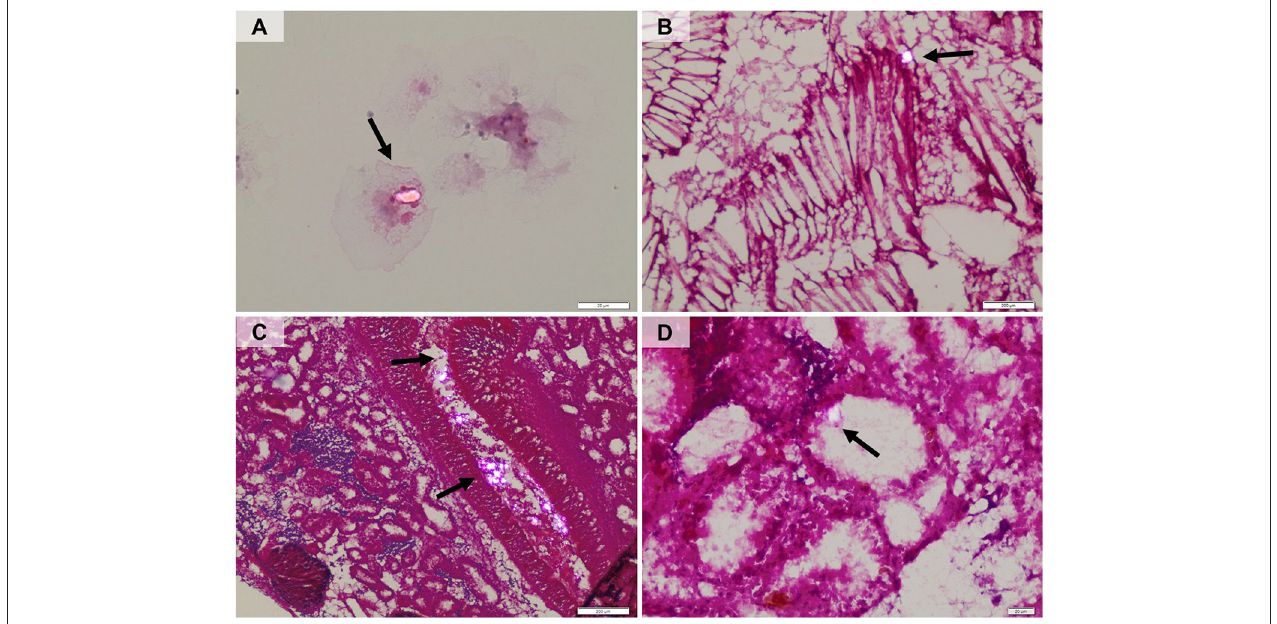
FIGURE 2 | Polarized-light microscopy images showing the presence of microplastic particles in hemolymph (A) , gills (B) , gut lumen and epithelium (C) , digestive tubules (D) .